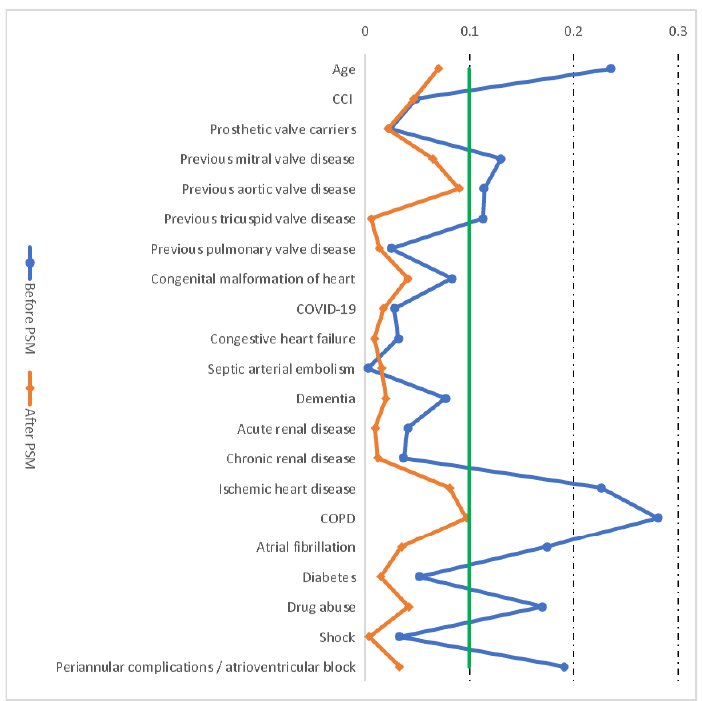
Figure 1. Love plot showing the comparison of covariate values for men and women: absolute standardized differences before and after propensity score matching (PSM). Green line shows the absolute standardized differences of 10%. Dotted lines show 20% and 30% standardized differences. Table 3. Distribution of isolated pathogens, therapeutic procedures, and hospital outcomes among women and men with infective endocarditis in Spain (2016–2020), before and after propensity score matching